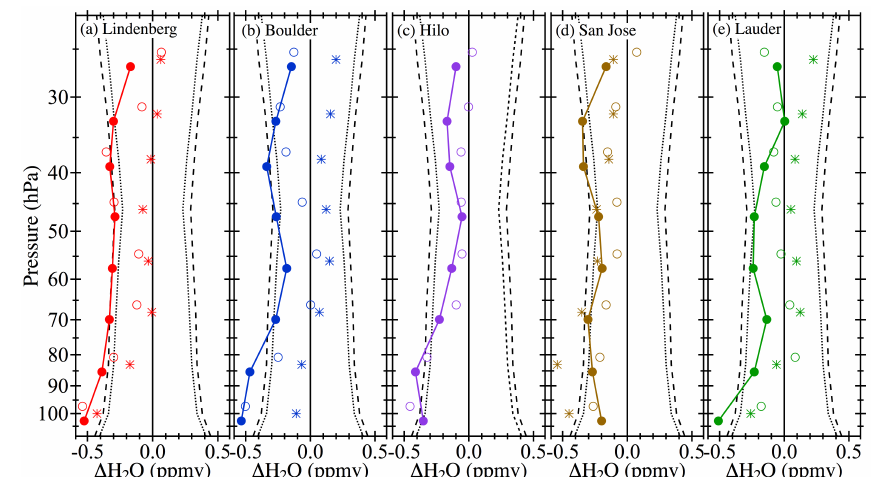
Figure 5. FP–MLS v3.3 differences at the starting points (open circles), changepoints (asterisks) and ending points (filled circles) of the time series as defined by piecewise continuous linear fits. Colored vertical curves join the ending points to serve as visual guides. Black vertical curves depict the combined accuracy estimates for FP and MLS measurements of stratospheric water vapor based on FP accuracy values of 3% (dotted) and 5% (dashed). Note that many of the ending point values lie near or outside the combined accuracy estimates. For Hilo only the starting and ending point differences are presented because no significant changepoints were detected in the shorter